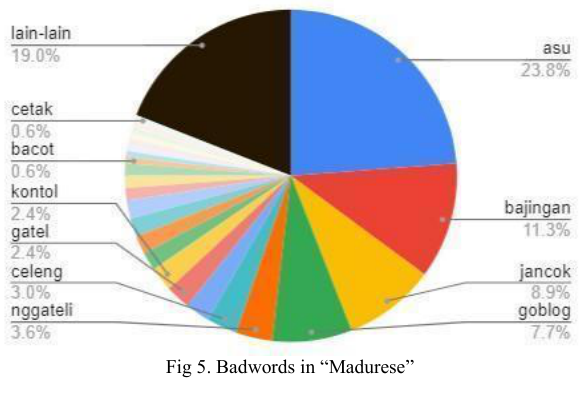
Fig 5. Badwords in